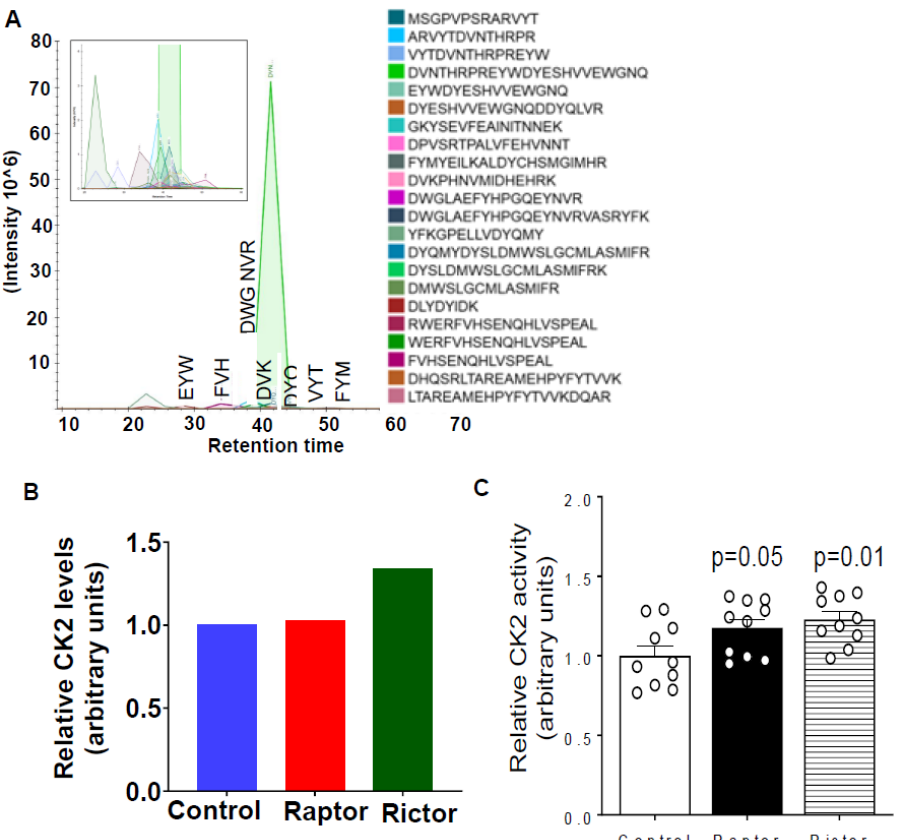
Figure 5. HepG2 cells incubated in CM from PHT cells with mTORC1 or mTORC2 inhibition increased CK2 activity. ( A ) Detection of CK2 peptides with PRM-MS; displaying chromatograms of individual peptides. The inset displays lower-intensity peptides. ( B ) Relative CK2 levels co-immunoprecipitated with IGFBP-1 from HepG2 CM after treatment with CM from PHT cells with either the control, RAPTOR (Rap), or RICTOR (Ric) siRNA. The total peak area for each treatment was normalized to that of the control. ( C ) CM from PHT cells with either mTORC1 or mTORC2 inhibition activated CK2 activity in HepG2.